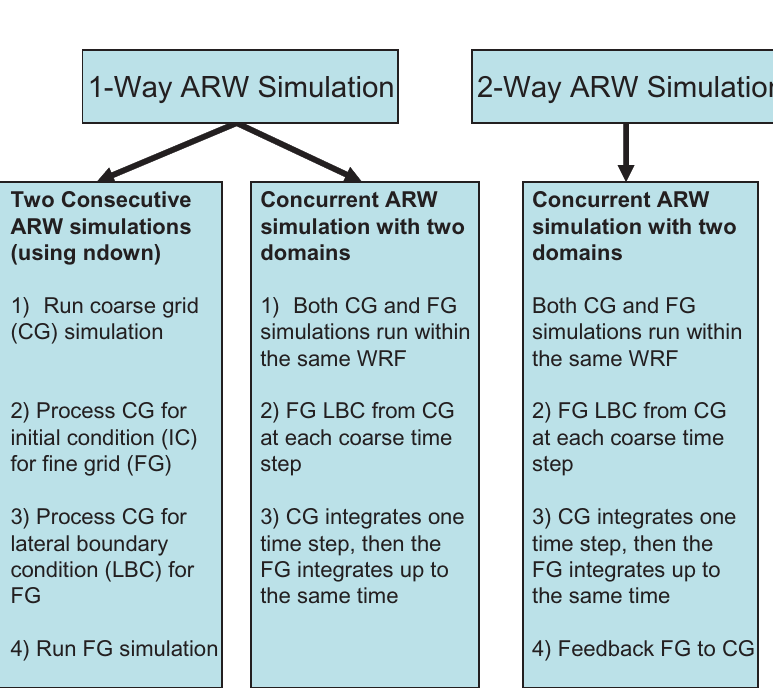
Figure 7.1: 1-way and 2-way nesting options in the